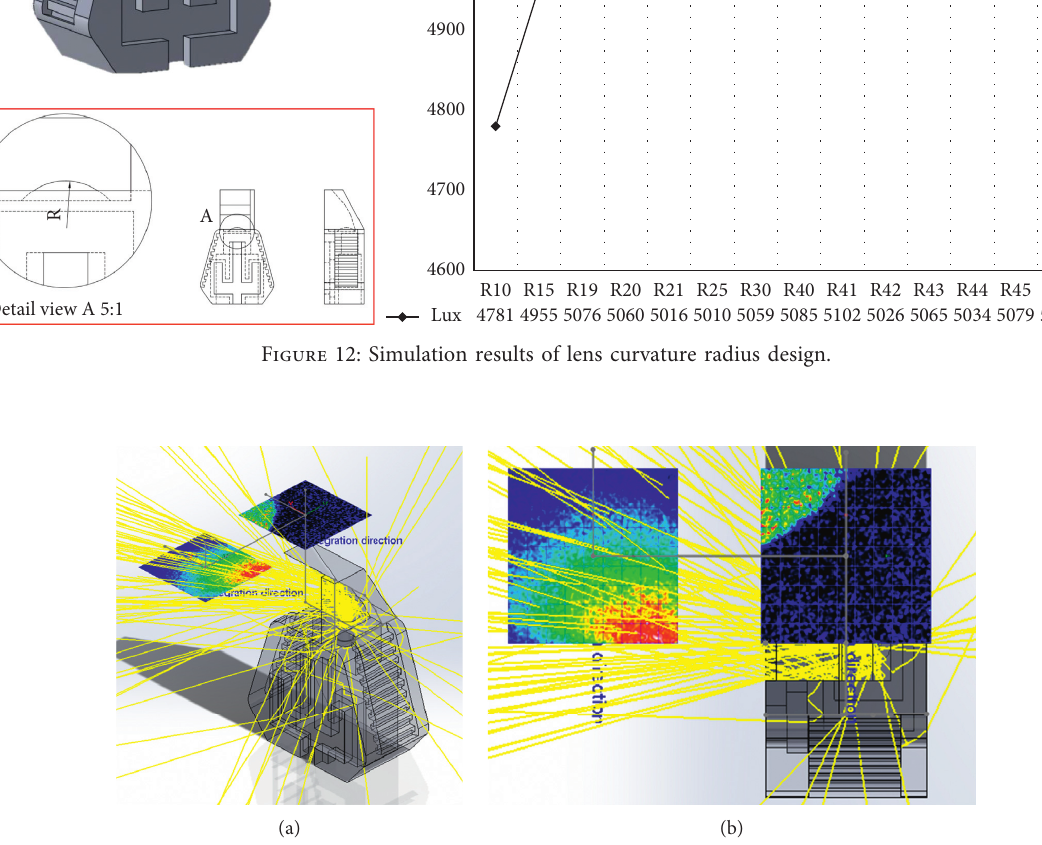
Figure 13: Simulation results of oral lighting optical microstructure device